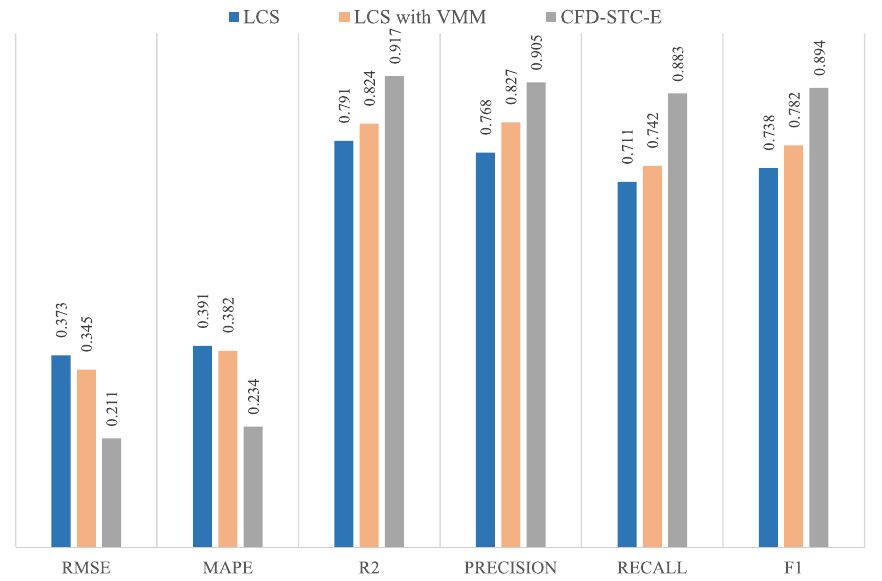
Fig. 14 Comparison of cascade fault detection effects of three methods